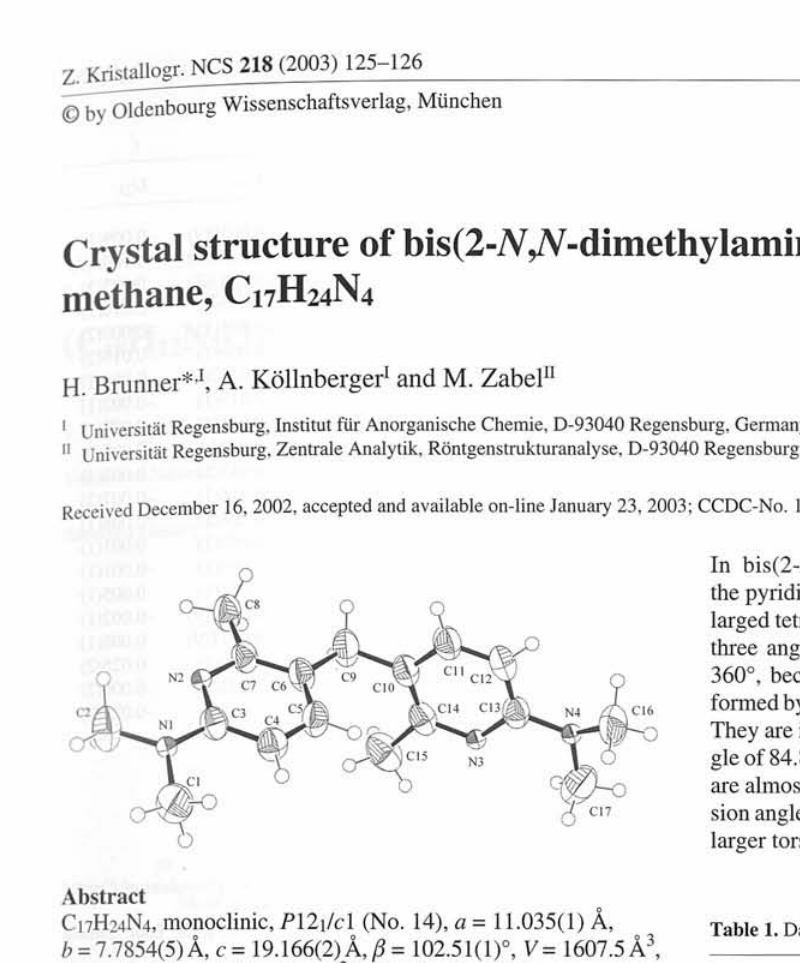
Table 1. Data collection and handling. Crystal: